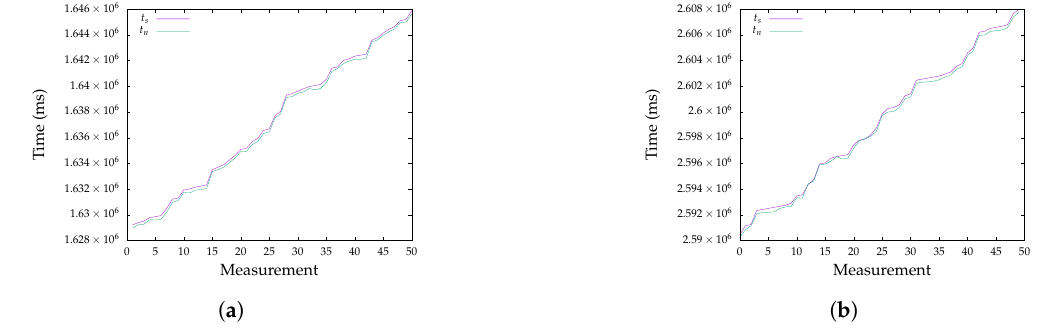
Figure 4. The Coordinator’s ( t s ) and Routers’ ( t n ) clocks for: ( a ) the first 50 measurements; and ( b ) the last 50 measurements.